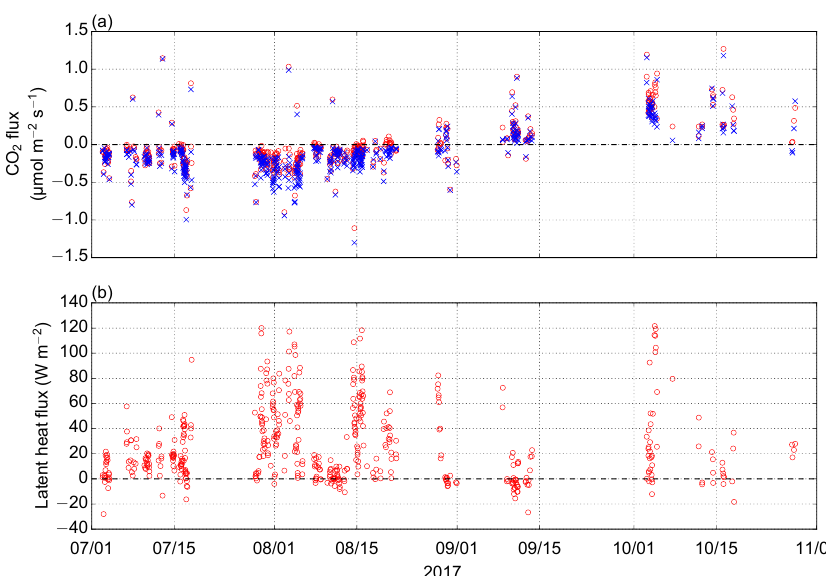
Figure 7. Sea–air fluxes of (a) CO 2 and (b) water vapor: standard setup (red circles) and test setup (blue crosses). Only the fluxes originating from the southwestern open sea sector (Fig. 1) are shown.